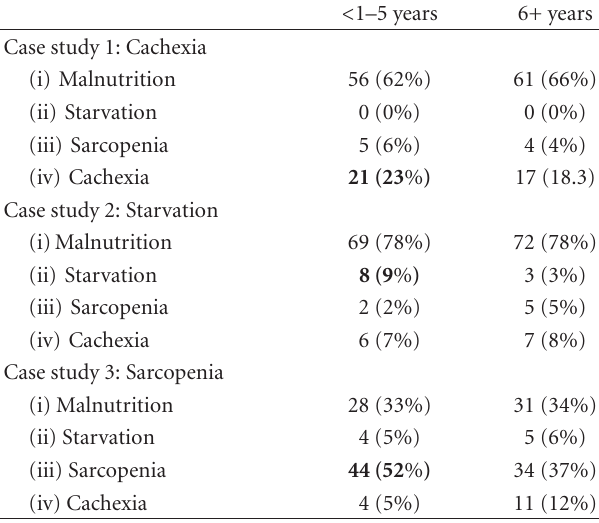
Table 3: Case study responses reported by respondents to a web- based survey of current attitudes and practices of members of the DAA, in regards to diagnosis and current dietary management of malnutrition, according to years of dietetic experience ( n